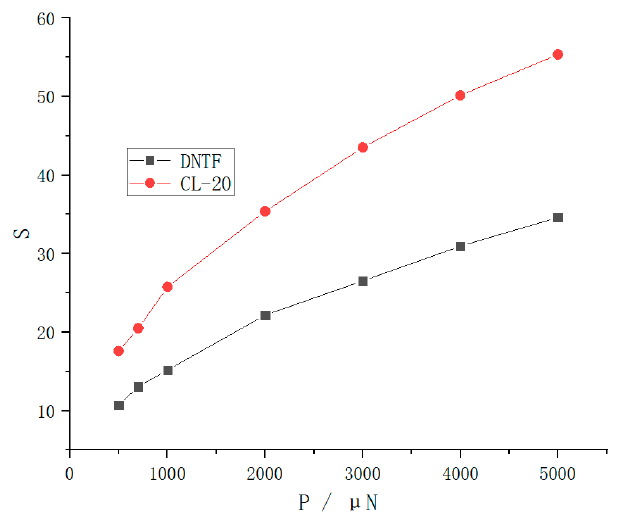
Figure 5. Load-contact stiffness variation curve.